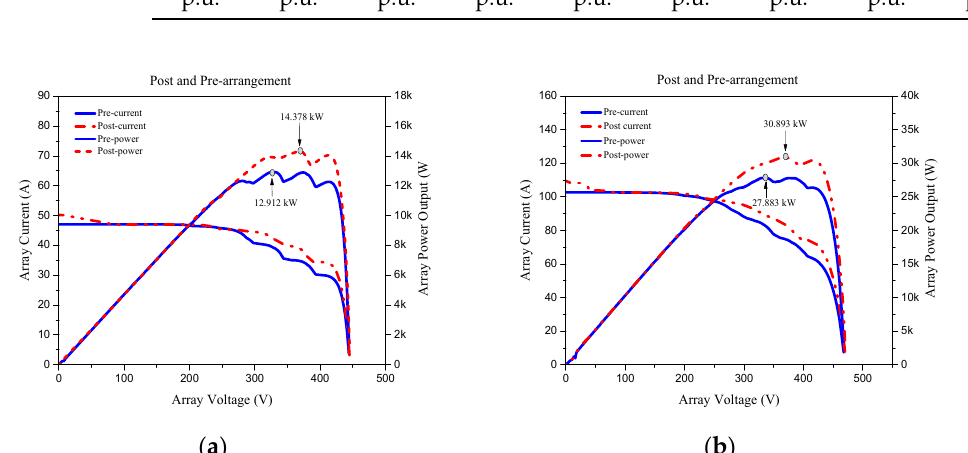
Figure 13. The outputs associated with the two types of 10 × 10 PV arrays, namely, 18-kW ( a ) and 43-kW ( b ) before and after the implementation of reconfiguration.